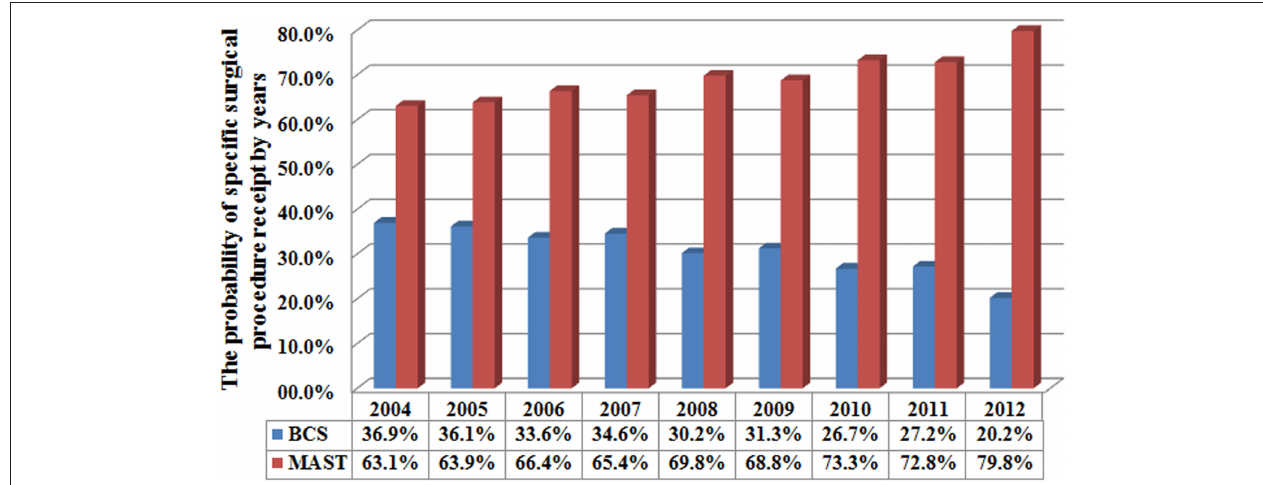
FIGURE 1 | Utilization of breast-conserving surgery and mastectomy during the studied period.